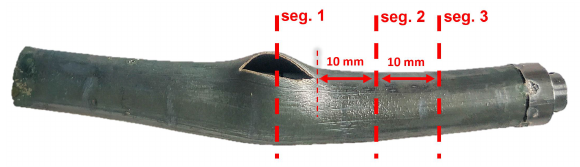
Figure 8. Ring segments cut for microscopy